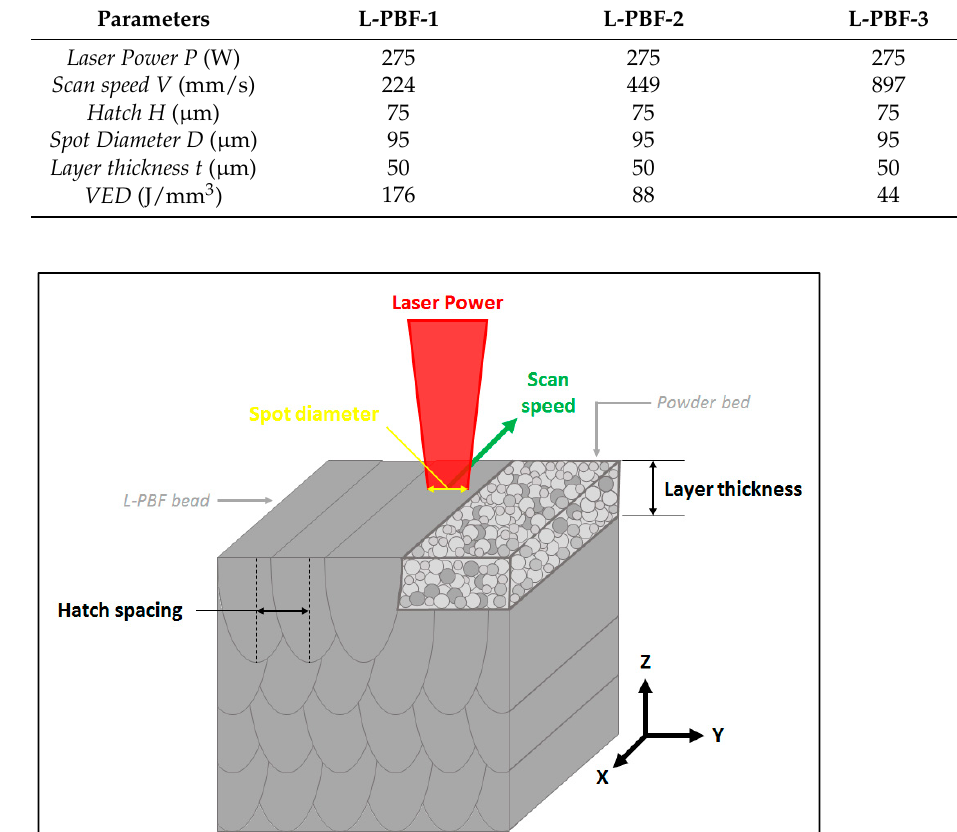
Figure 1. Schematic process of the main manufacturing parameters of the laser-powder bed fusion (L-PBF) approach.